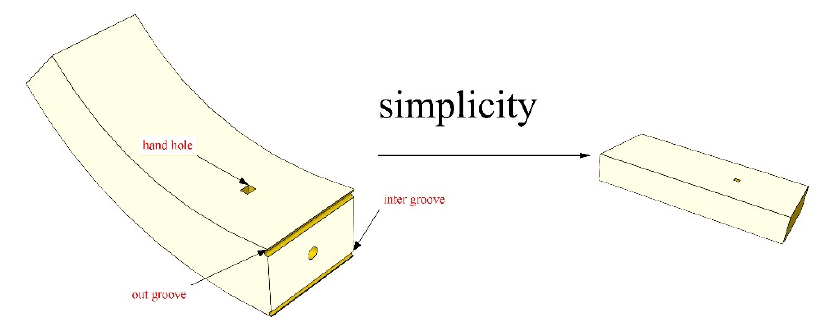
Figure 1. Simplified diagram of segmental joints.